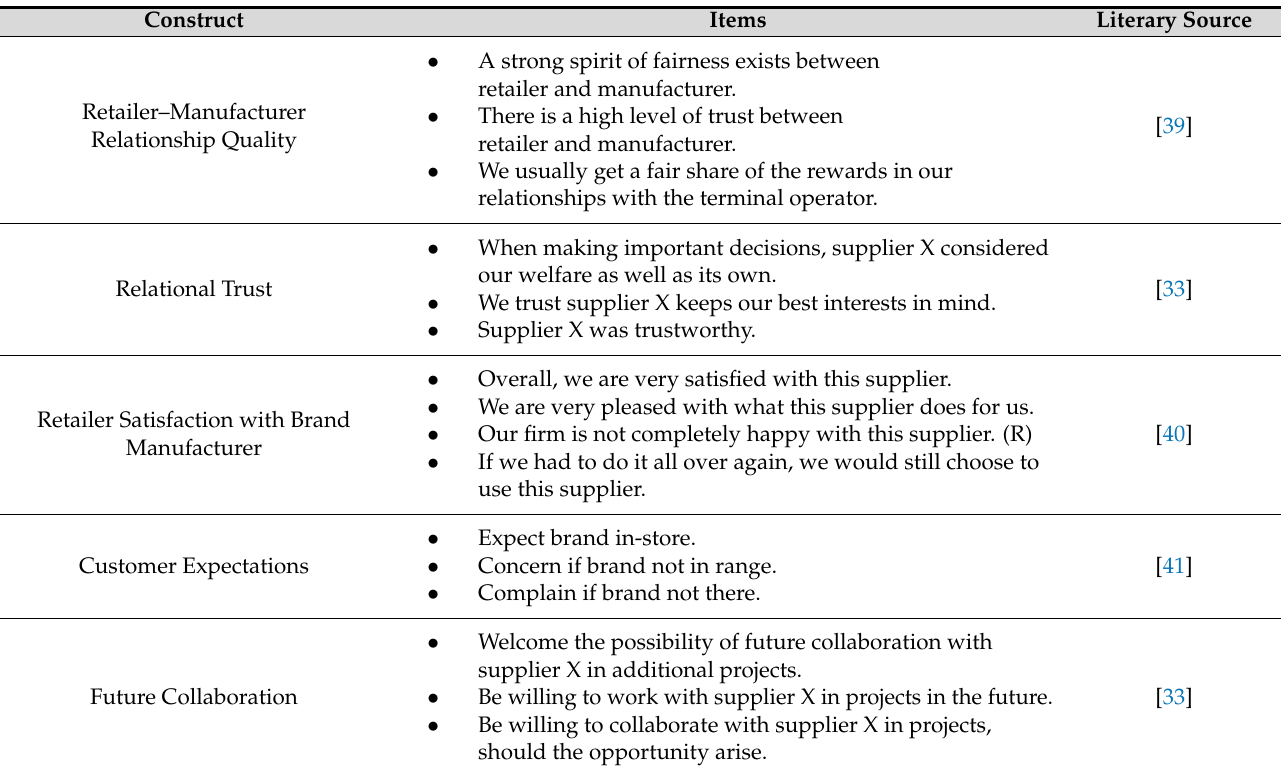
Table 1. Sources of the measure